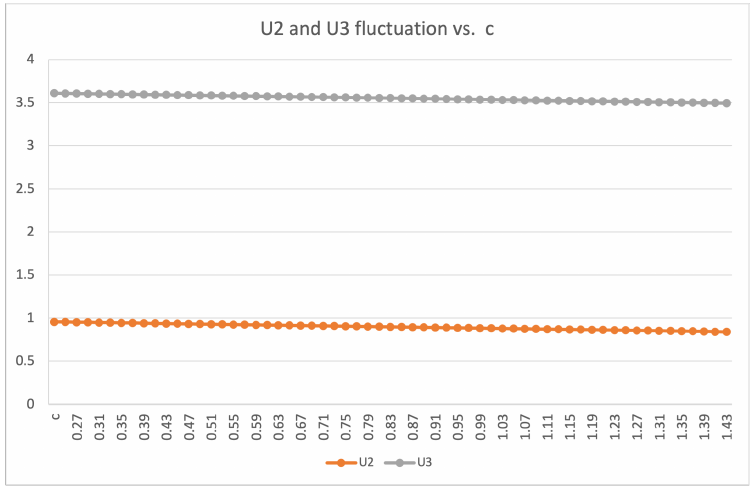
Figure 4. Calculated U-values based on variation of c 1 .